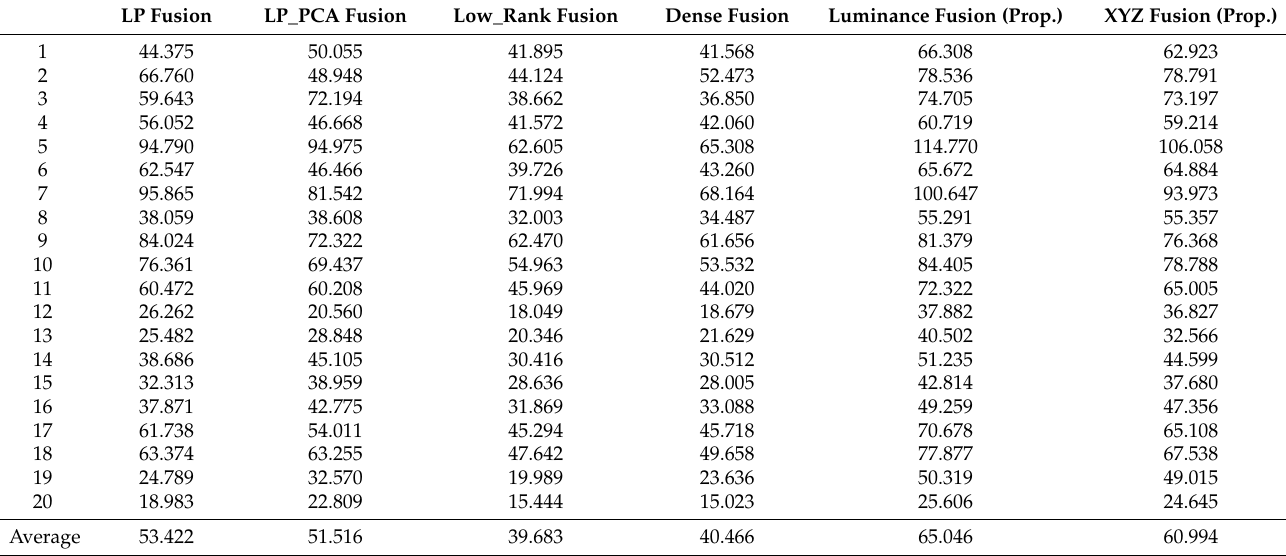
Table 11. Comparison of the Edge intensity